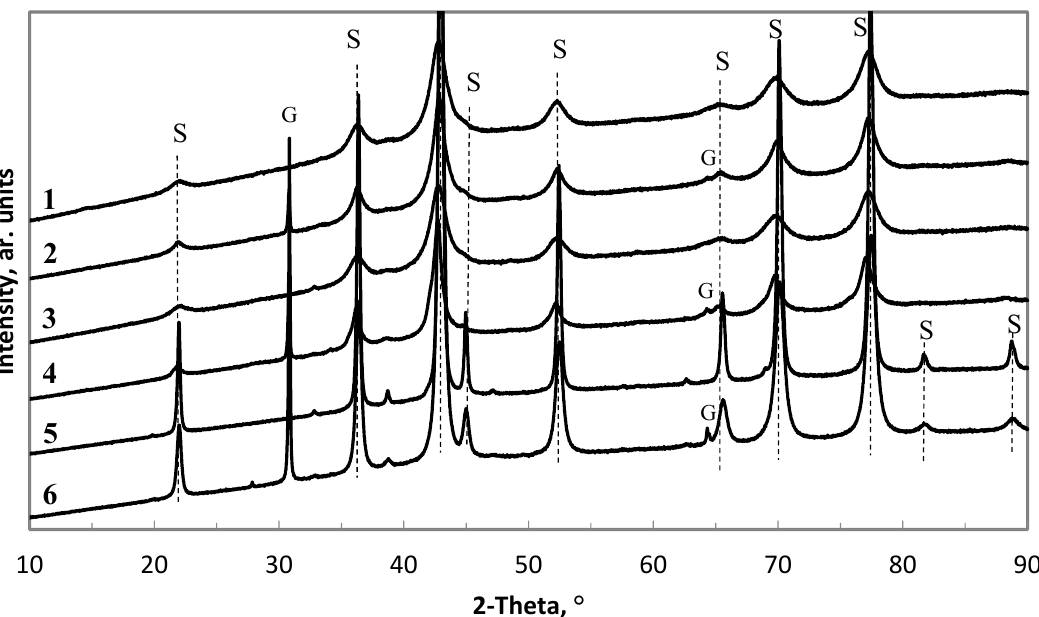
Figure 5. XRD patterns of the laboratory and commercially prepared catalysts: ( 1 ) K/Co 4 MnAlO x -lab; ( 2 ) K/Co 4 MnAlO x -industry; ( 3 ) Cs/Co 4 MnAlO x -lab; ( 4 ) Cs/Co 4 MnAlO x -industry; ( 5 ) Cs/Co 3 O 4 -lab; ( 6 ) Cs/Co 3 O 4 -industry. Phase designation: S—spinel, G—graphite.